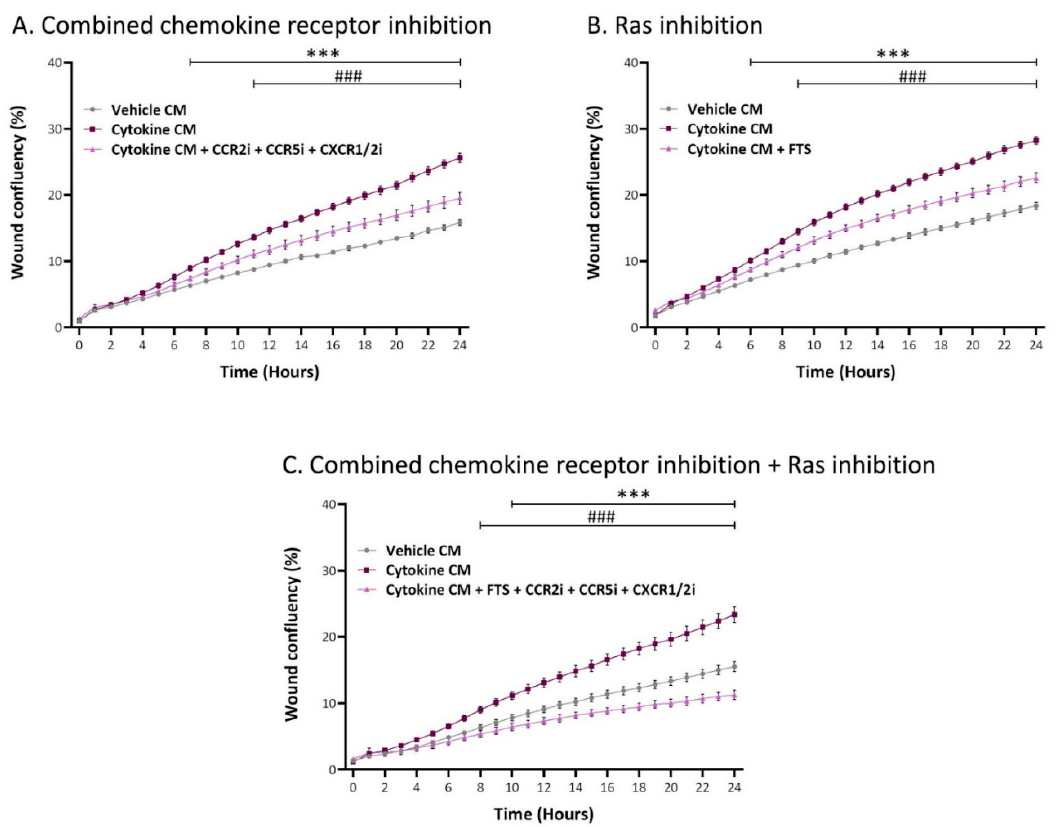
Figure 12. Tumor cell migration, elevated by inflammatory CAF-derived factors, is mediated through cooperativity between Ras-activating receptors and chemokine receptors. Human MSCs were exposed to persistent TNF α + IL-1 β stimulation (concentrations as in Figure 1) or to vehicles, generally for 14–18 days. Cytokine-devoid CM were collected as described in Figure 7 and were administered to MCF-7 cells in the presence of inhibitors. In the same experiment, different inhibitory conditions were used: ( A ) combined inhibition of CCR2, CCR5, and CXCR1/2 together, as in Figure 11. ( B ) Inhibition of Ras-mediated signaling by FTS. ( C ) Combined inhibitory measures directed to chemokine receptors and Ras-mediated signaling. In all treatments, cell numbers and viability were not affected by the inhibitors (except for the inhibitory treatment included in part C, where 15–25% decrease in cell numbers was noted). Kinetics analyses of wound closure assays were performed in IncuCyte ® , as described in Figure 9. The results are presented as mean ± SEM of 8–9 replicates for each treatment. *** p < 0.001, for differences between tumor cells treated by the CM of inflammation-derived CAFs and control CAFs. ### p < 0.001, for differences between tumor cells treated by the inhibitors and tumor cells that were not treated by the inhibitors. The results of a representative experiment out of n = 3 are